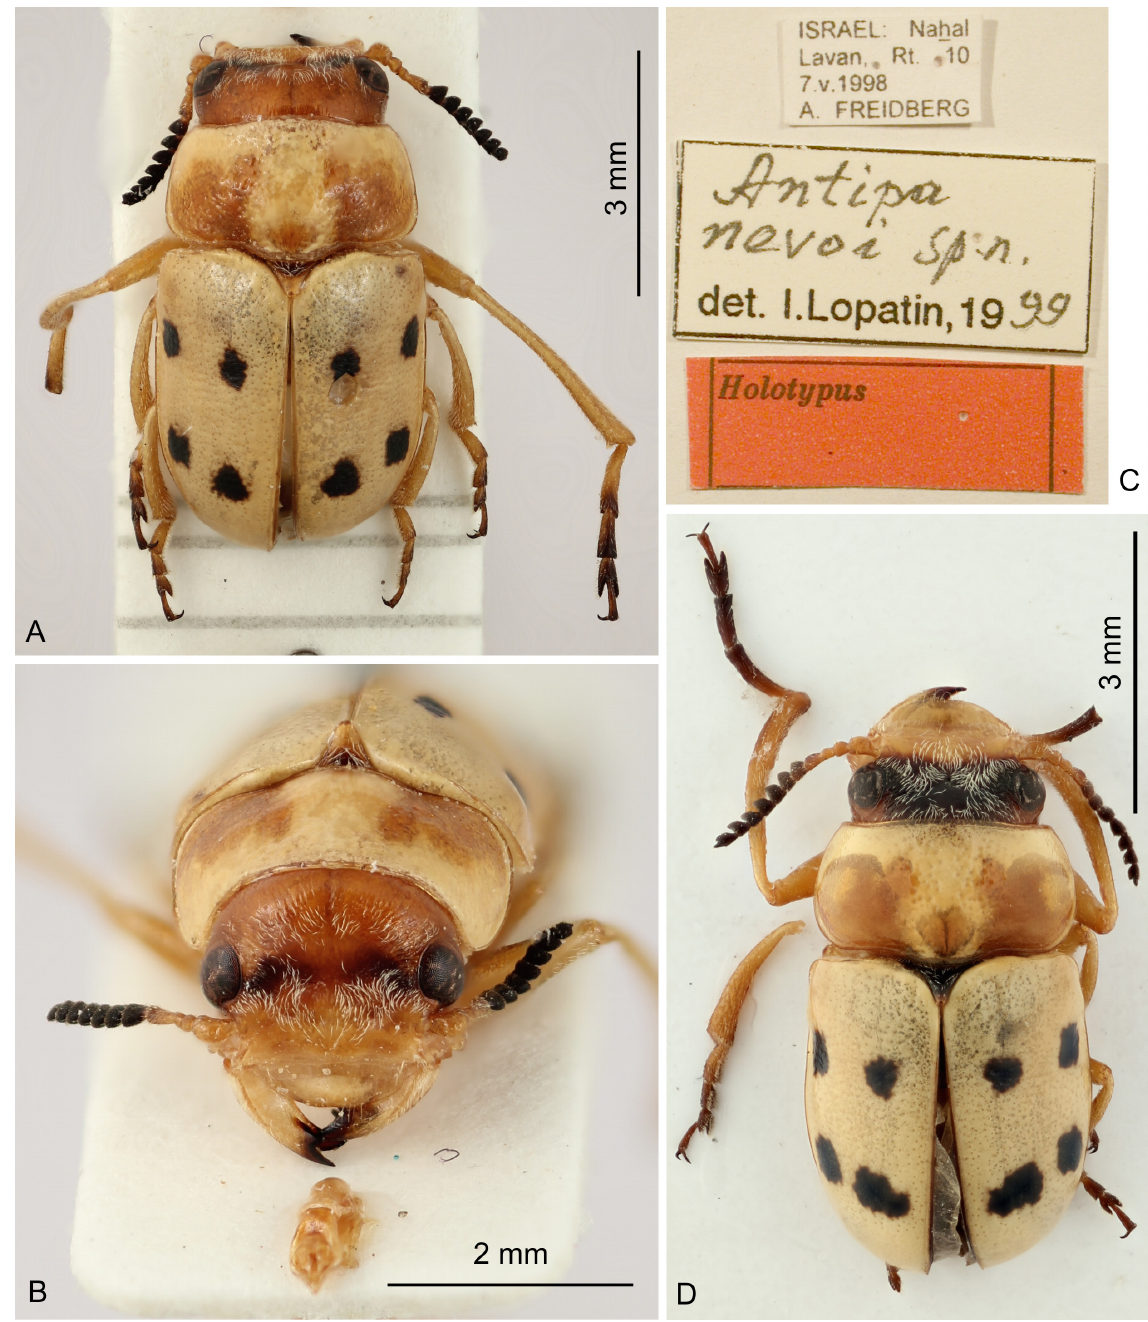
Fig. 13. Tituboea nevoi Lopatin & Chikatunov, 2001. A – C . Holotype, ♂, 6.2 mm (TAU). A . Dorsal view. B . Frontal view. C . Labels. D . ♂, 6.3 mm, Libya